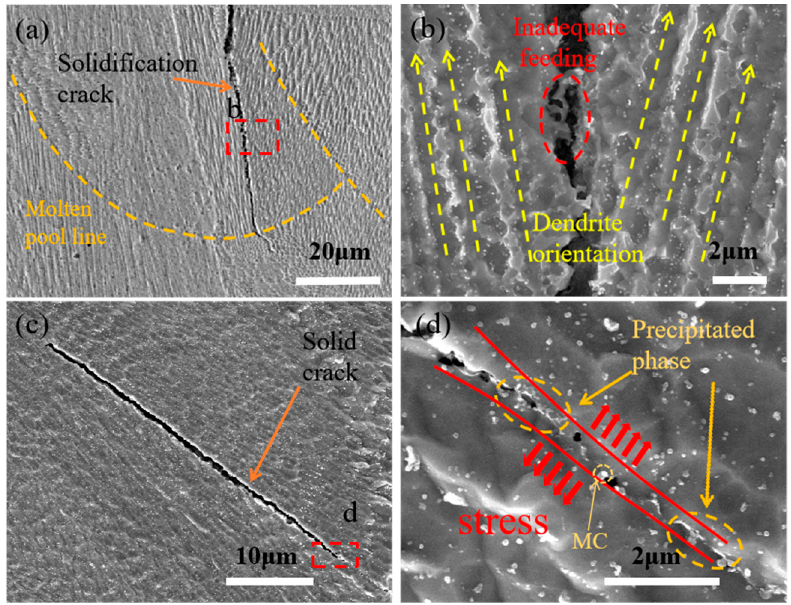
Figure 5. ( a ) Solidification crack; ( b ) Local amplification of the area inside the dotted box in ( a ); ( c ) Solid crack; ( d ) Local amplification of ( c ).